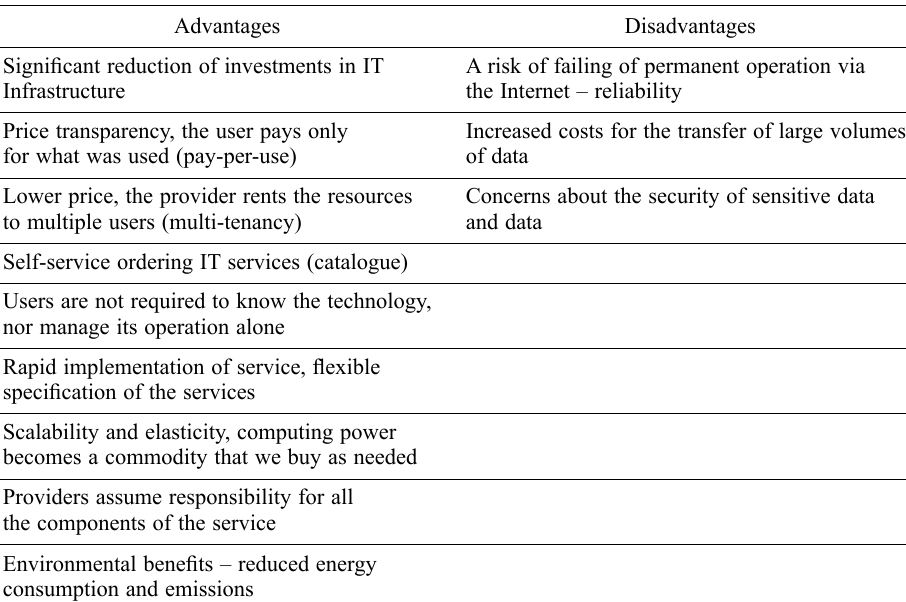
Table 3. Pros and cons of CC